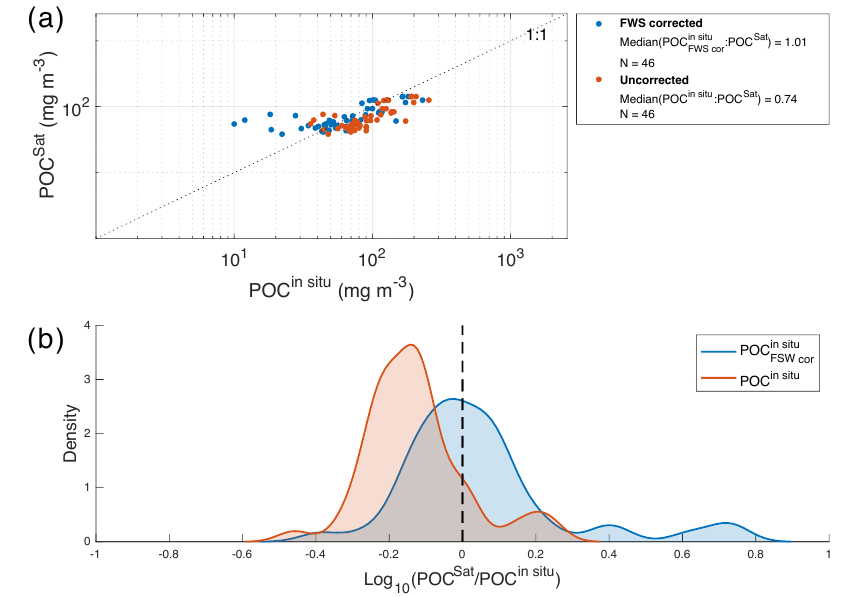
Figure 4. ( a ) Comparison between measured POC (POC insitu ) and retrieved (POC Sat ) for box 1 with a time window of 12 h. Blue and orange dots indicate dry-blank corrected samples (POC insitu ) and filtered seawater corrected blanks (POC insitu ) respectively; the dashed line shows the 1:1 relationship. FSW − cor ( b ) Probability density function of the logarithm base 10 of the ratio between POC Sat and POC insitu (orange line) and POC insitu (blue line); the statistics of the comparisons are listed in Table FSW − cor